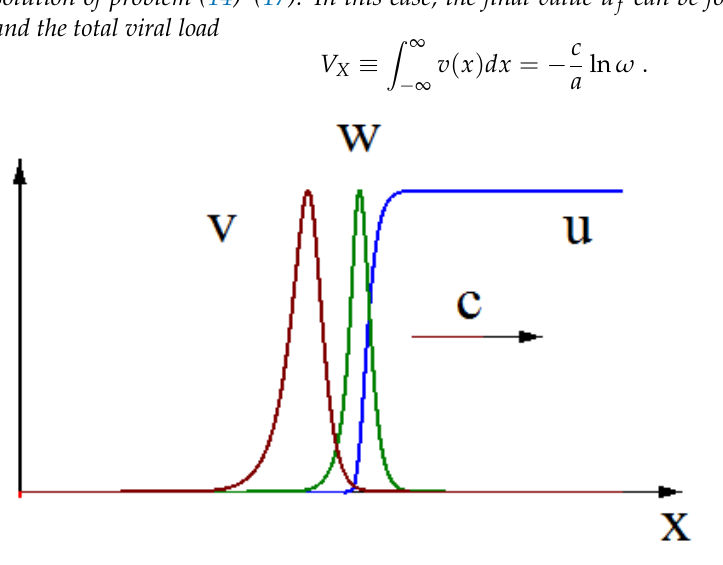
Figure 1. A snapshot of numerical solution of system (11)–(13). Infection spreads as a reaction- diffusion wave with a speed c , U ( x , t ) = u ( x − ct ) , I ( x , t ) = w ( x − ct ) , V ( x , t ) = v ( x − ct ) . Note that u f = 0